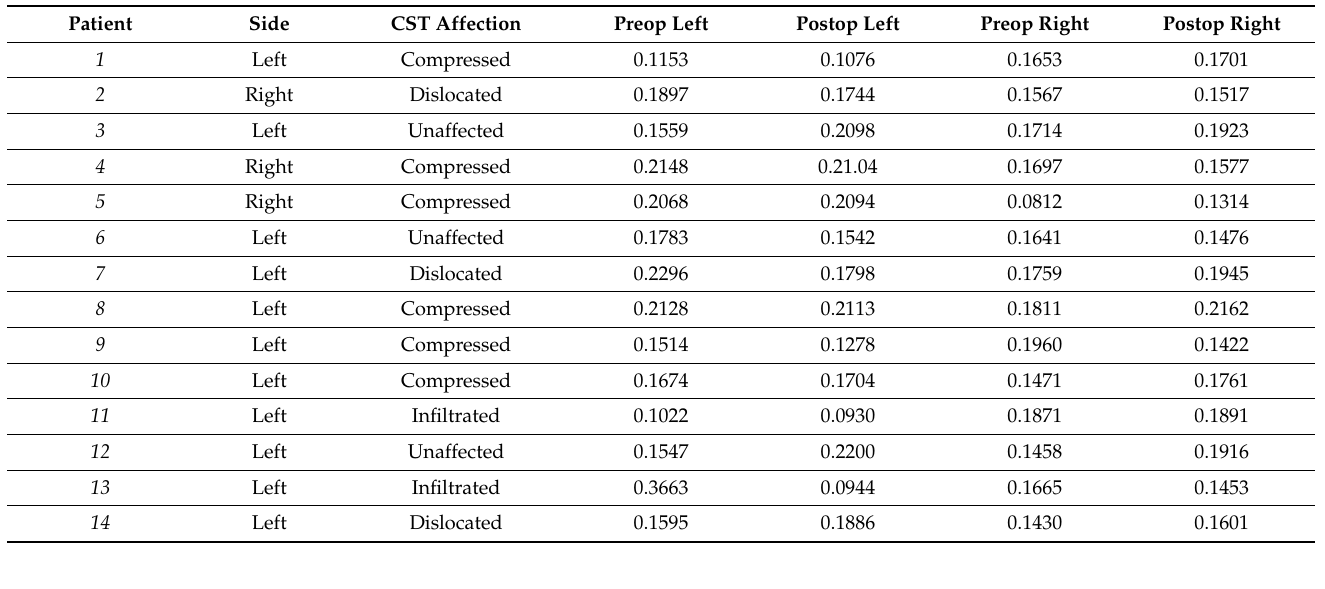
Table 2. The fifth percentile of the FA values in each reconstructed CST. The side of the affected hemisphere and the CST affection are given for comparison. Note that infiltrated or compressed CSTs had a significantly lower fifth percentile of FA values (0.1407 ± 0.0109 versus 0.1763 ± 0.0040, p = 0.0036).